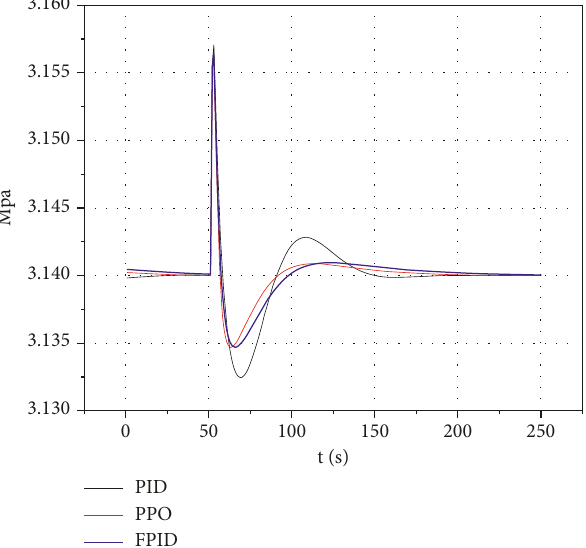
Figure 15: Simulation curve of steam pressure with feed water temperature steps down to 50 ° C.